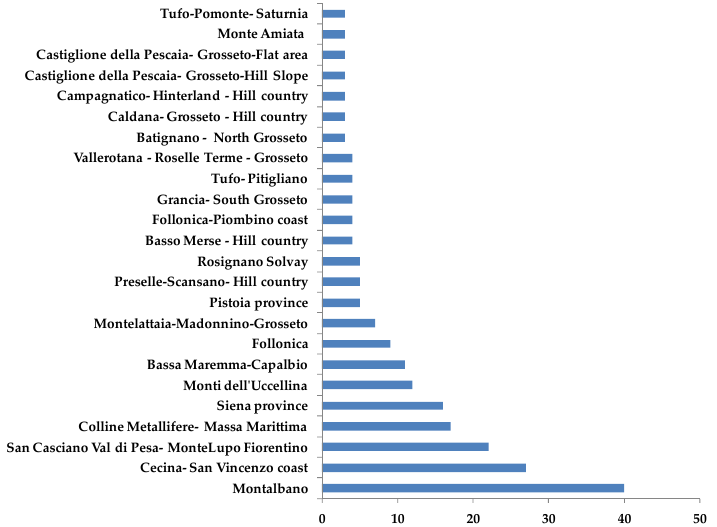
Figure 11. Bars-chart representing samples (supplied by Certified Origins Italia s.r.l .) distribution in the geographical reference areas.